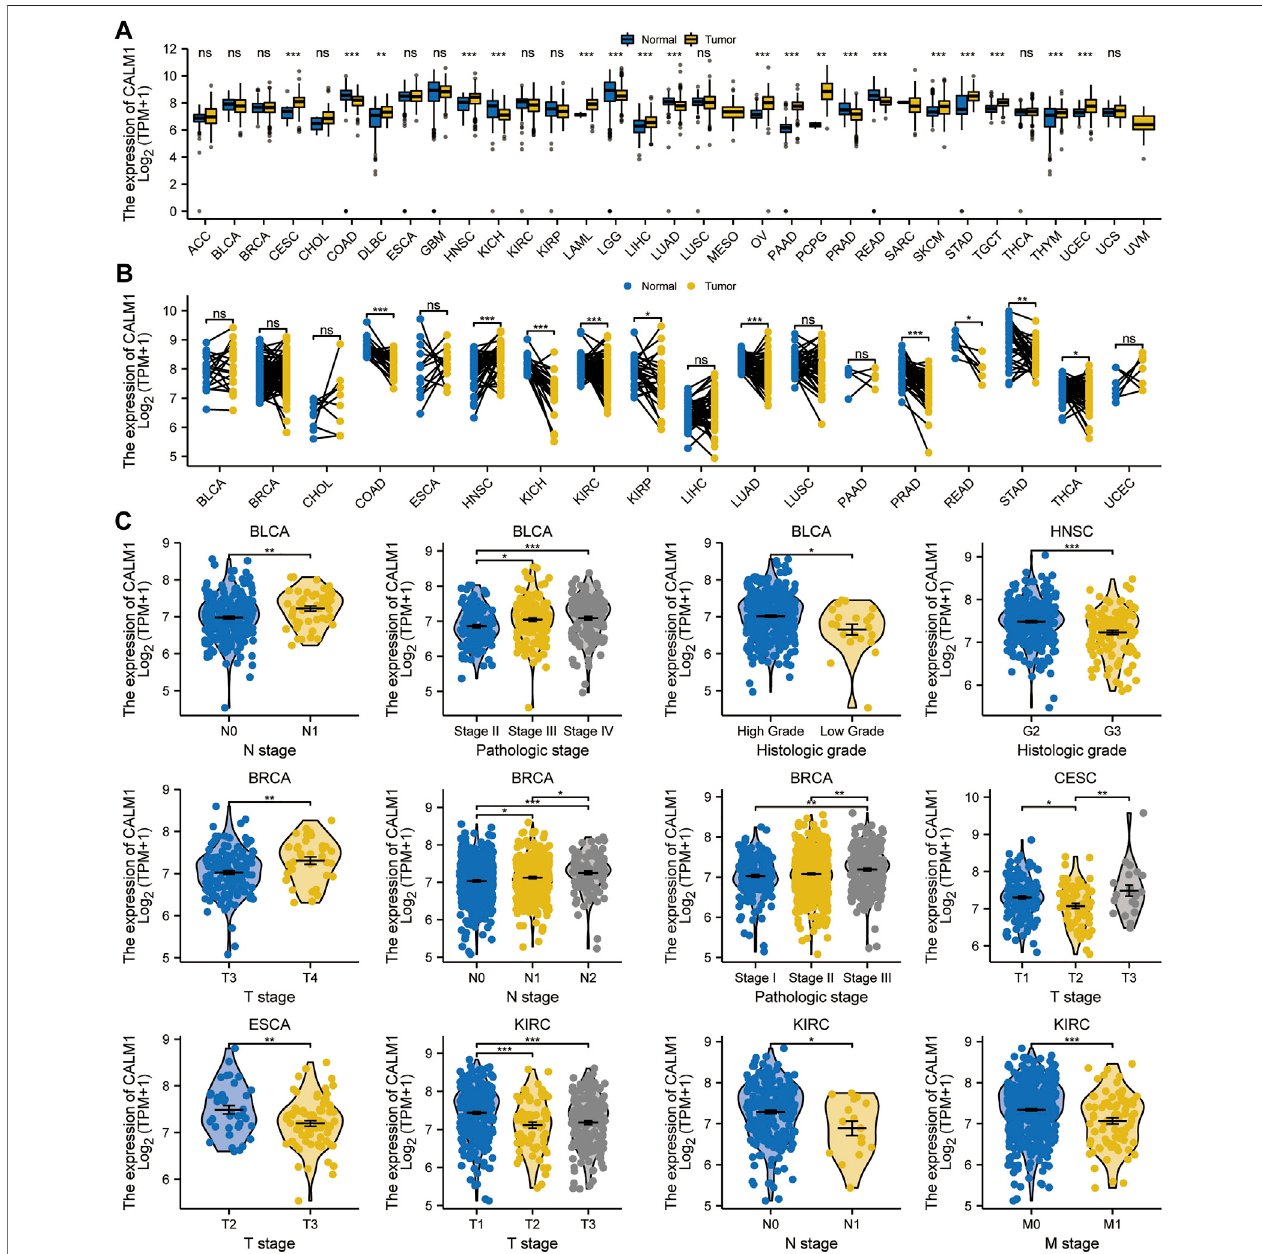
FIGURE 1 | Expression levels of CALM1 gene in human cancers and relevant clinical features. (A, B) Expression levels of CALM1 mRNA in cancer and adjacent/ paired normal tissues. * P < 0.05; ** P < 0.01; *** P < 0.001; ns, no signi fi cance. (C) Relationship between CALM1 mRNA expression and clinical features in human cancers. * P < 0.05; ** P < 0.01; *** P <